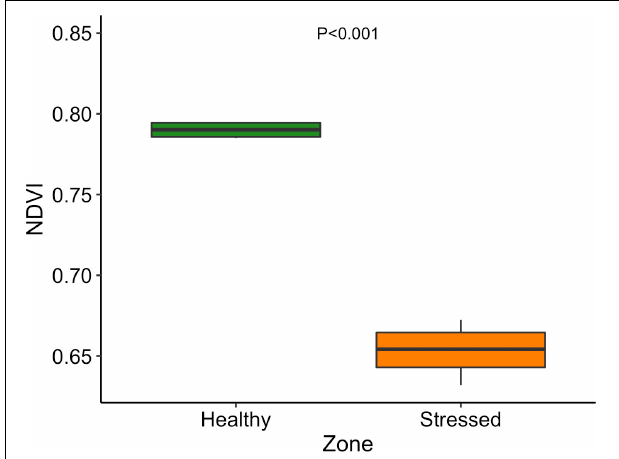
FIGURE 7 | Normalized Difference Vegetation Index of “stressed” and “healthy” Avicennia marina at the St Kilda mangrove forest, South Australia. The measurements were taken on the second youngest leaves. Four leaves were measured from each plant and four plants were measured from each zone.